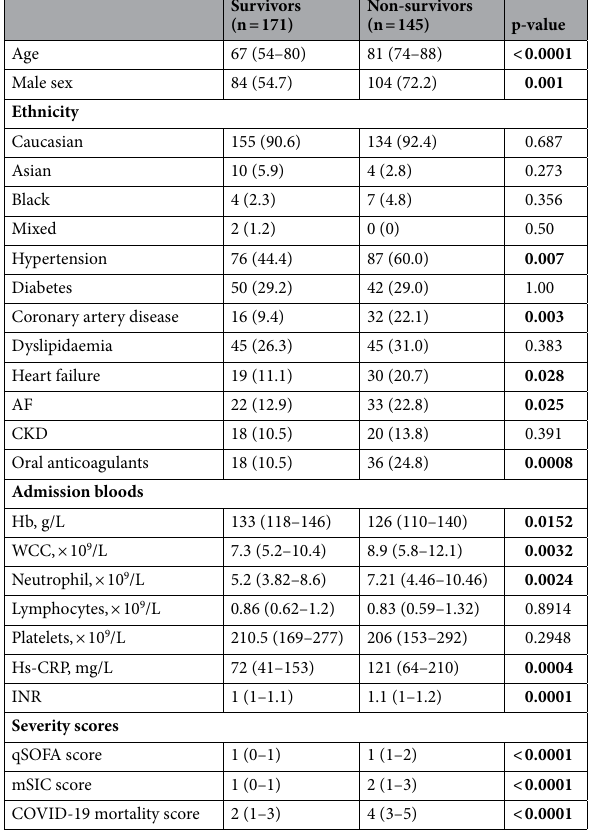
Table 1. Baseline patient characteristics on admission. AF Atrial Fibrillation, CKD Chronic Kidney Disease (defined as eGFR of less than 60 mL/min/1.73 m 2 ), Hb Haemoglobin, WCC White cell count, CRP C-reactive protein, INR International normalised ratio, qSOFA quick Sepsis-related Organ Failure Assessment score, mSIC modified Sepsis-Induced Coagulopathy score. Bold values indicate p < 0.05.